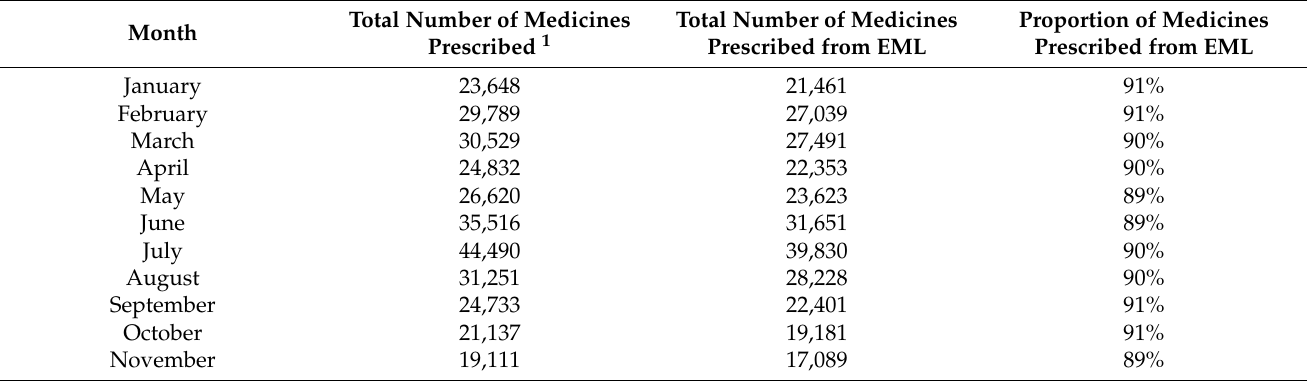
Table 5. Number and proportion of medicines prescribed from the Ghana Essential Medicines List among outpatients of the University Hospital, KNUST in